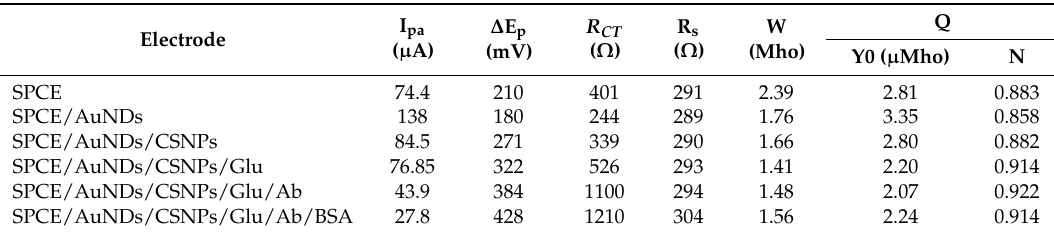
Table 1. Randles’ and CV parameters for step by step fabrication of proposed immunosensor related to Figure